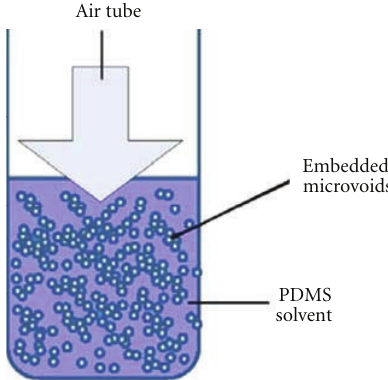
Figure 13: Embedded microvoids PDMS polymer solvent.